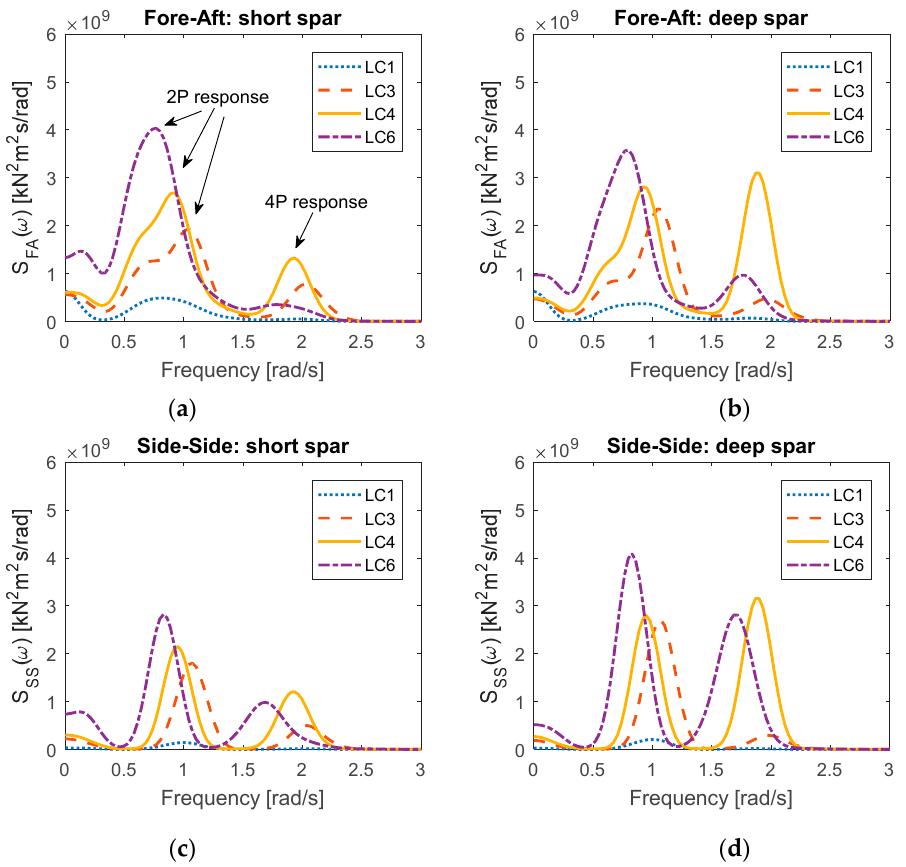
Figure 13. Power spectra of tower base bending moment under all loading cases: ( a ) Short spar VAWT in fore–aft direction; ( b ) Deep spar VAWT in fore–aft direction; ( c ) Short spar VAWT in side–side direction; ( d ) Deep spar VAWT in side–side direction.